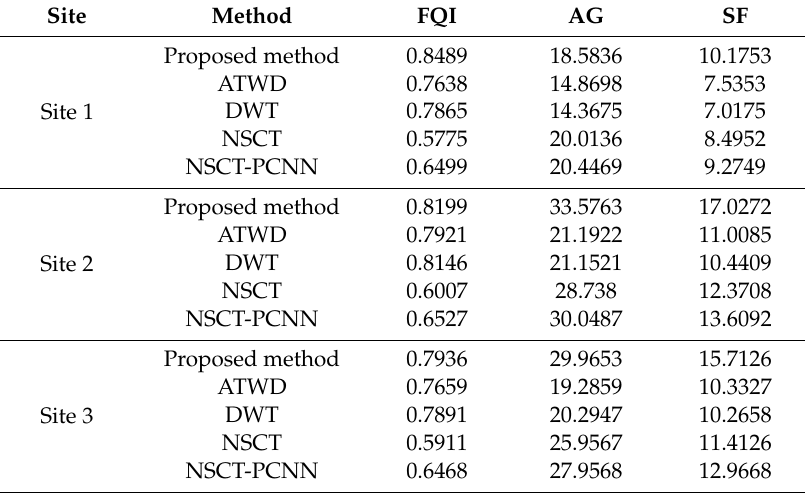
Table 2. Evaluations for the image fusion methods (FQI: fusion quality index, AG: average gradient, SF: spatial frequency, ATWD: à-trous wavelet decomposition, DWT: discrete wavelet transforms, NSCT: non-subsampled contourlet transform, NSCT-PCNN: non-subsampled contourlet transform-pulse couple neural network).